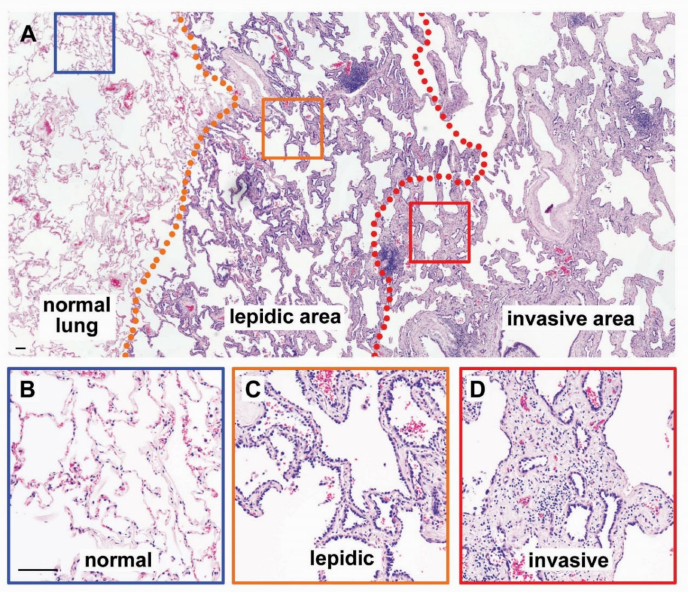
Figure 3. Morphological heterogeneity in lung adenocarcinoma. A representative hematoxylin and eosin stain of human lung adenocarcinoma is presented. ( A ) Low-magnification picture that shows the transition from normal lung tissue to invasive cancer. The orange dotted line delimits the transition from normal tissue to well-di ff erentiated (lepidic) cancer. The red line delimits the transition from well-di ff erentiated (lepidic) to invasive cancer. The areas delimited by the blue, orange, and red squares are shown in the bottom panels at higher magnification; ( B – D ) Higher magnifications of the areas of normal lung ( B ), lepidic adenocarcinoma ( C ), and invasive adenocarcinoma ( D ) highlighted by the color-coded squares. Scalebars, 100 µ